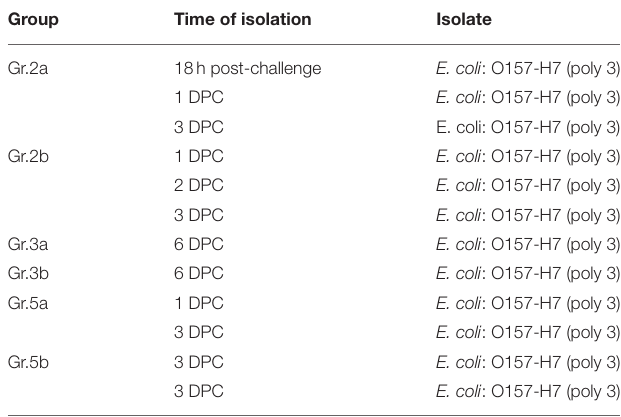
TABLE 6 | Serology results for different groups 10 days post-challenge, Experiment 2.